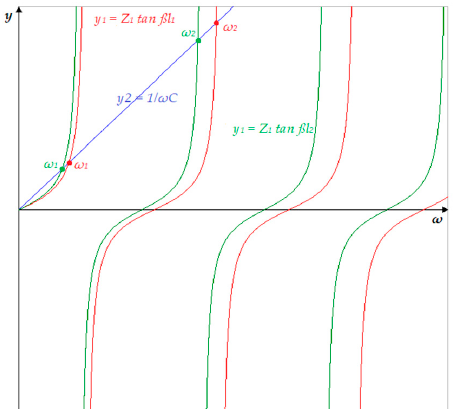
Figure 7. Graphical determination of the resonant frequency for a coaxial resonator with a branch length l .